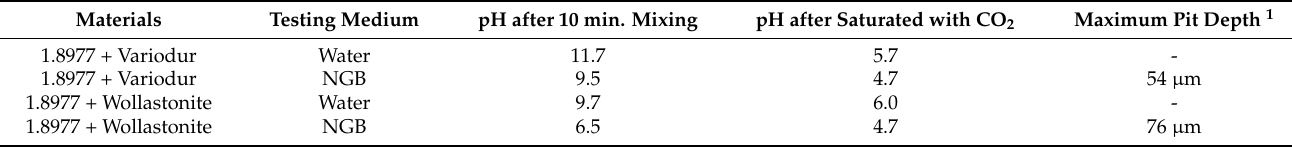
Table 4. Effects of cement suspension on the pH of testing solutions and maximum pit depth.